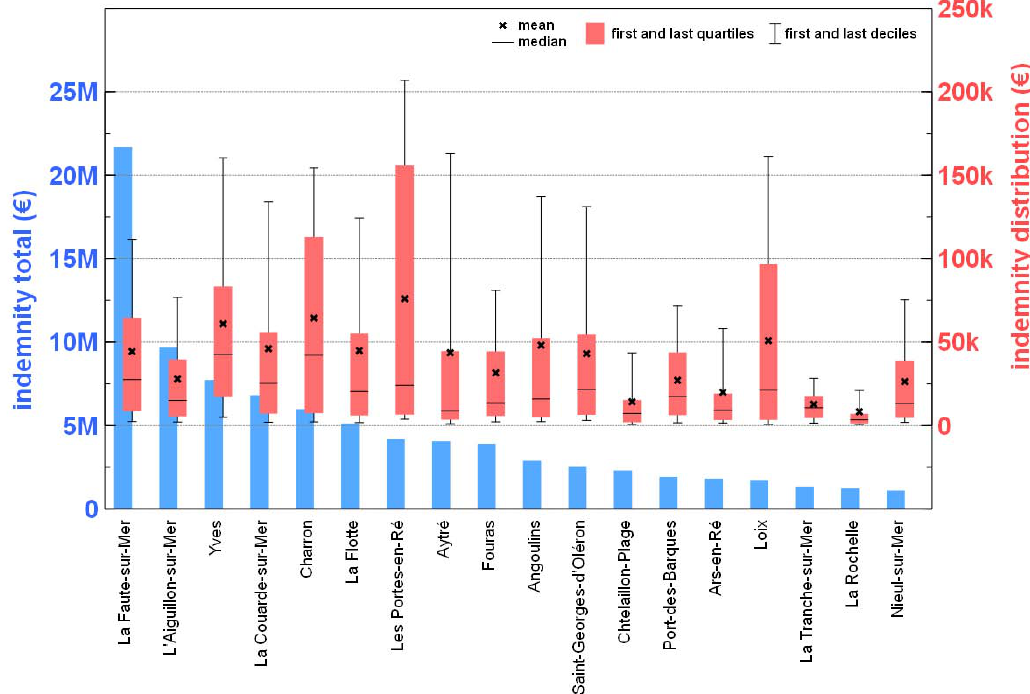
Fig. 3. Total sum of indemnities (in blue) and indemnity distribution (in red) for residential building damages, in towns having a total indemnity of at least 1million C, for the three insurance companies that took part in the study. The resulting dataset is believed to represent around 25% of the overall insurance market in